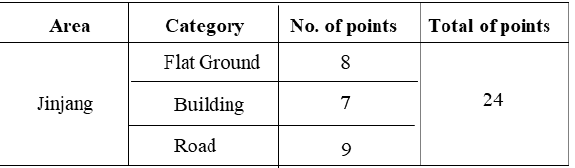
Table 4 . Distribution of checkpoint for ground survey